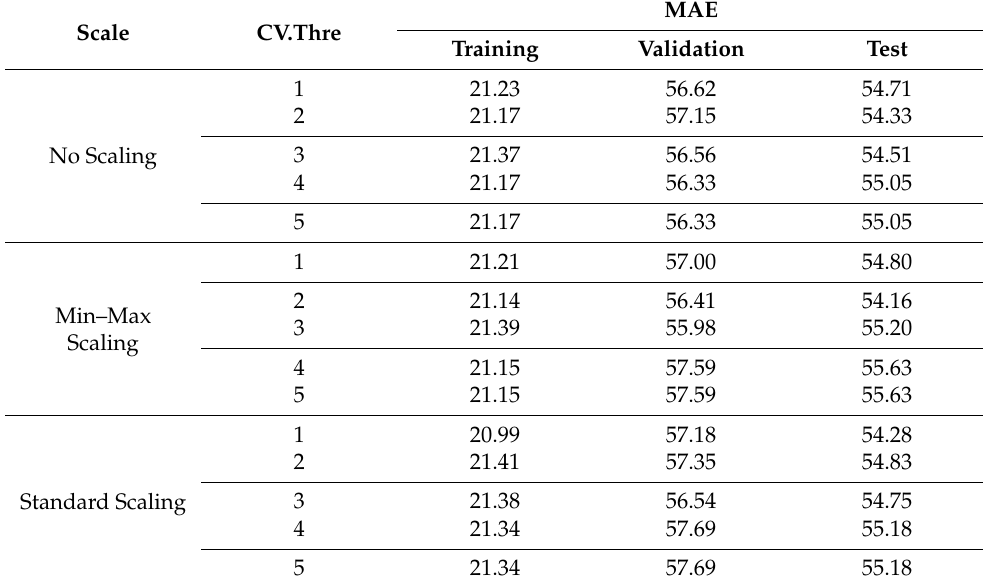
Table 8. MAE for different scales and CV thresholds for